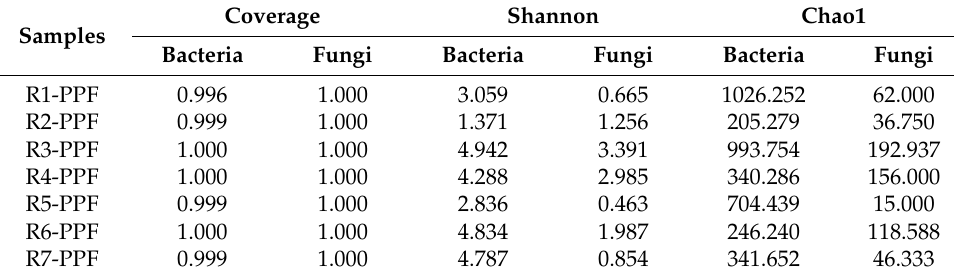
Table 2. Analysis of microbial diversity in different